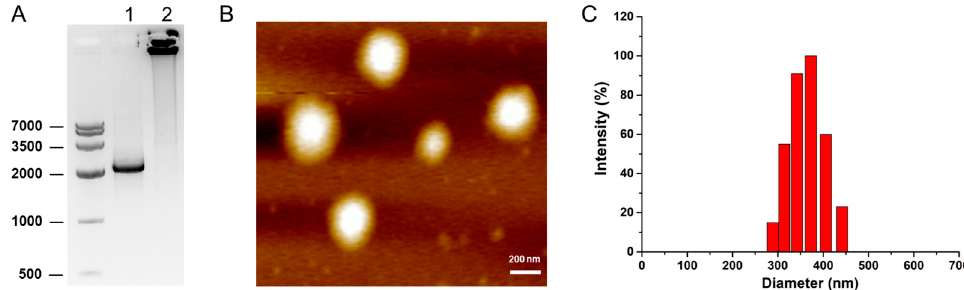
Figure 2. Construction and characterization of NP-TP53-shMYC. ( A ) Results of 1% agarose gel analysis for NP-TP53-shMYC. 1. L-TP53-shMYC; 2. NP-TP53-shMYC. ( B ) AFM analysis of NP-TP53-shMYC. Scale bar: 200 nm. ( C ) DLS analysis of NP-TP53-shMYC.